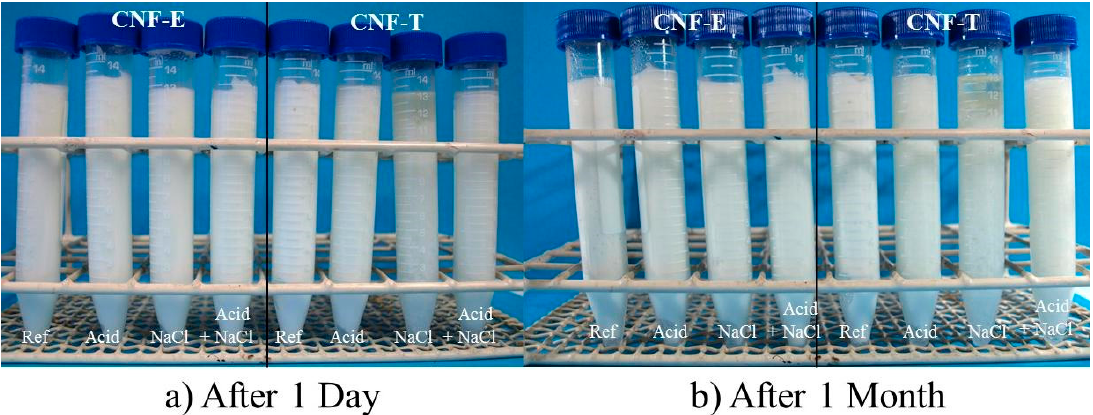
Figure 2. Pictures of the CNF-stabilized emulsions with 0.5 wt % CNFs, containing acetic acid and/or salt. The pictures are taken after ( a ) one day and ( b ) one month of storage at 23 °C.